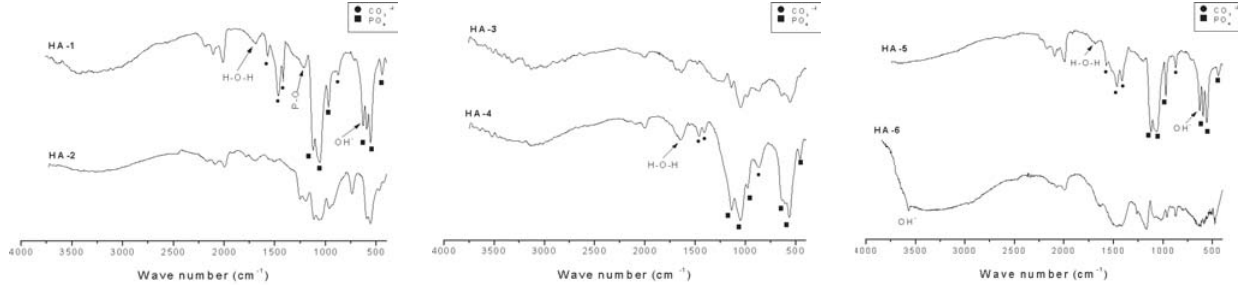
FIGURE 3- FTIR spectra of samples